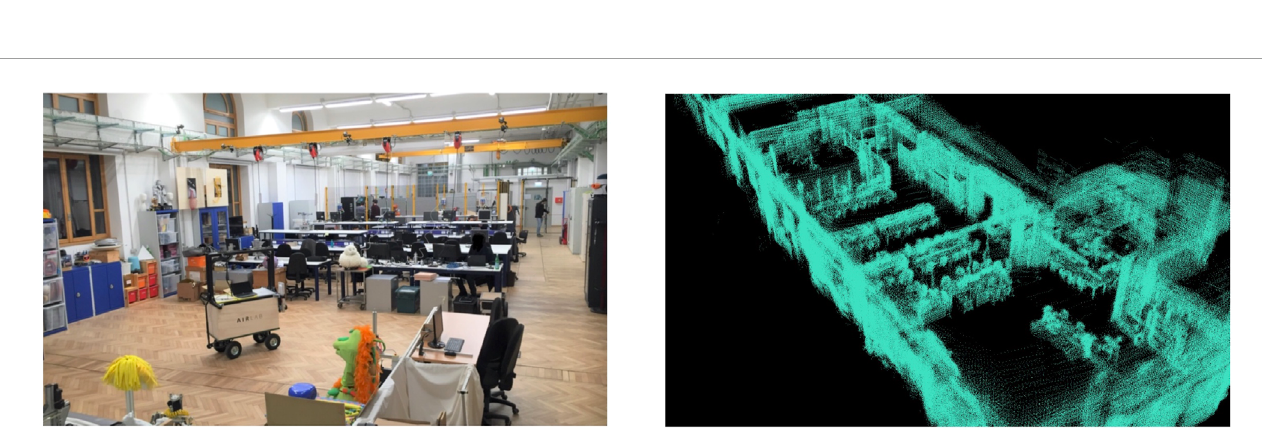
FIGURE 3 Indoor area of the experimental campaigns. It consists of a long laboratory (left panel) with many obstacles, visible in the map, as a point cloud (right panel), obtained with HDL Koide et al. (2019).